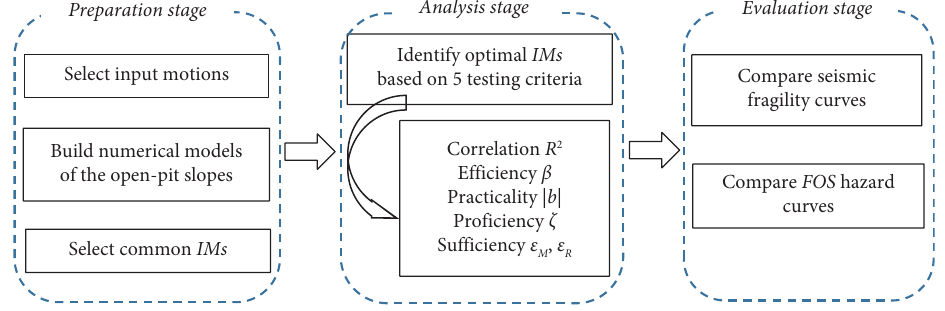
Figure 1: Flowchart of the analytical framework to identify the optimal IMs for the open-pit